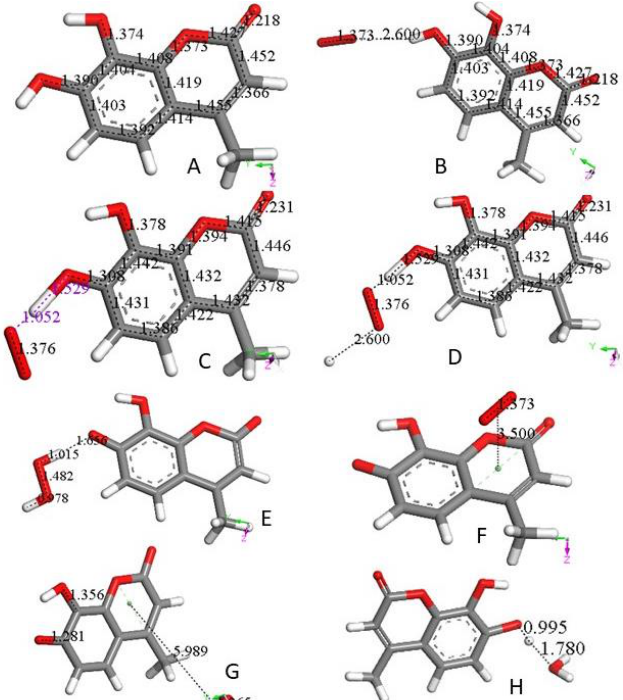
Figure 1. ( A ) 4-Methyl-7,8-di-hydroxy-coumarin was geometry optimized. C–C and C–O bonds are displayed for comparison in following figures. ( B ) A superoxide molecule (O–O bond distance 1.373 Å) was van der Waals posed by H7, 2.60 Å. ( C ) After geometry optimization of the arrangement shown in ( B ) O7–H7 breaks (1.529 Å), and H7 is captured by superoxide (1.052 Å). ( D ) A proton is van der Waals posed near the superoxide, 2.60 Å in the arrangement shown in ( C ). ( E ) Geometry optimization of ( D ) structure results in formation of H 2 O 2 , well separated from O7(polyphenol), 1.656 Å. This was followed by H 2 O 2 elimination, and minimization of the remaining neutral coumarin radical. ( F ) A superoxide radical is π - π posed on top of the pyrone ring (van der Waals separation, 3.50 Å). ( G ) Geometry optimization of ( F ) arrangement shows formation of a O 2 molecule